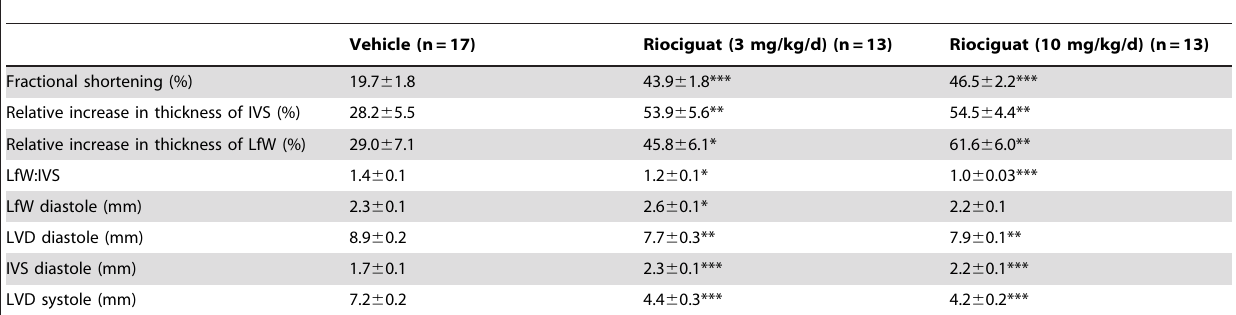
Table 2. Cardiac echocardiographic measurements in the vehicle- and riociguat-treated Dahl/ss rats maintained on a high-salt